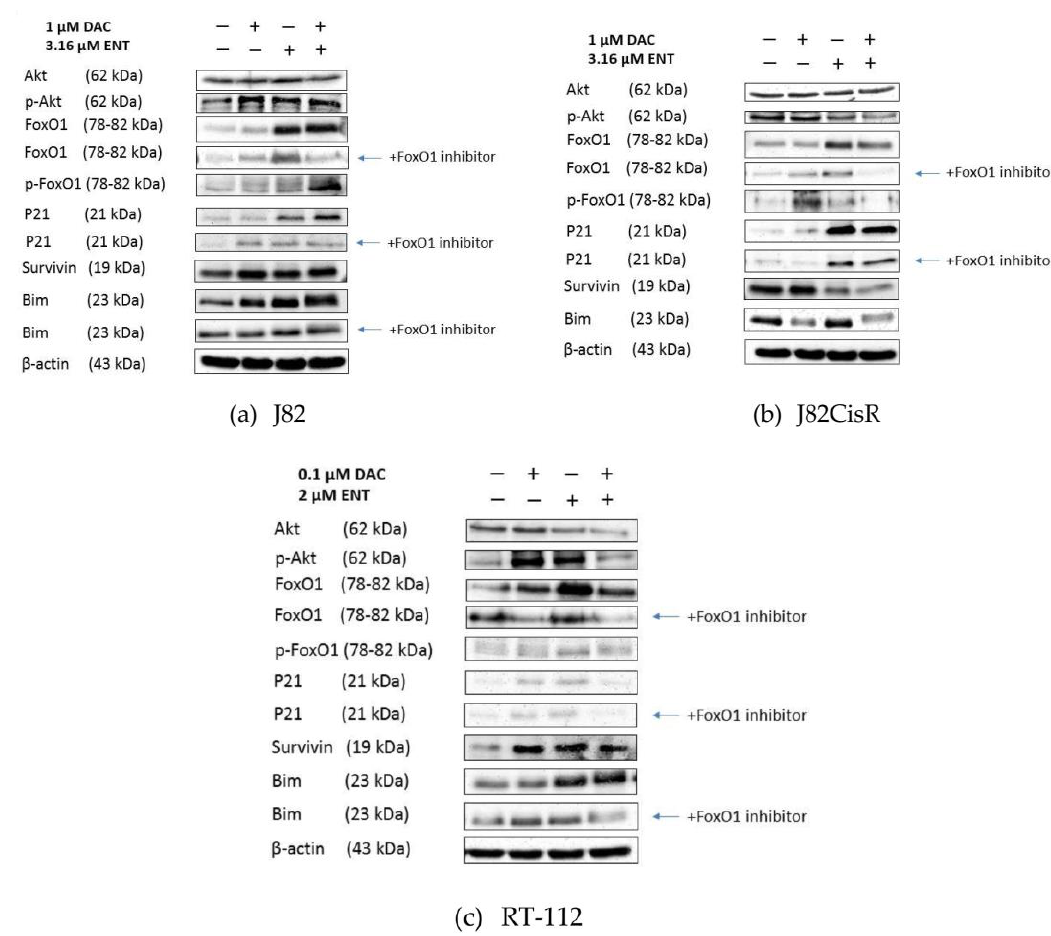
Figure 6 . Epigenetic treatments alter protein expression in urothelial bladder cancer cell lines. ( a – c ) Western blot analysis of J82, J82CisR, and RT-112 cell lines upon the treatment of DAC and ENT. Cells were treated for 48 h with DAC followed by 48 h treatment with ENT. DMSO was used as a solvent control; the blots shown in ( a – c ) are from one representative experiment out of a set of three experiments.